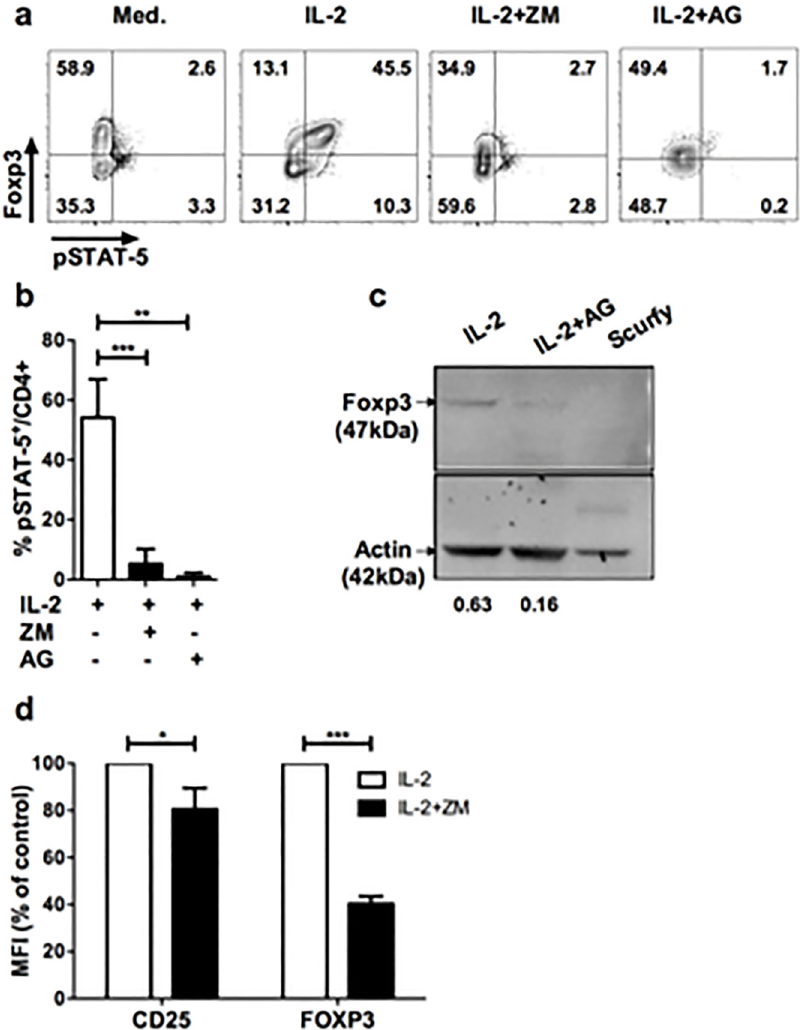
Fig 1. Blockade of JAK/STAT signaling pathway leads to down modulation of Foxp3 in Treg. ( a ) CD25-enriched T cells were cultured for one hour in complete medium alone (Med.), with IL-2 (IL-2), or IL-2 supplemented with ZM-39923 (IL-2+ZM) or AG-490 (IL-2+AG). Profiles shown are gated in CD4 + cells and are representative of 4 independent experiments. ( b ) Frequencies of pSTAT5 + cells among CD4 + cells cultured for one hour with IL-2 alone (IL-2) or in presence of IL-2 and the indicated JAK inhibitors (ZM, AG). Results are compiled from 4 independent experiments. (c) In vitro expanded CD4 + GFP + Treg were treated with IL-2 and with either 100ug/mL of AG490 (IL-2+AG) or vehicle control (absolute ethanol; EtOH) for 2 hrs (IL-2). Proteins were extracted in lysis buffer and blotted followed by anti-Foxp3 and anti-actin staining. Intensity values were normalized to the actin band in each blot. The specificity of the Foxp3 staining is attested by the absence of the Foxp3 band in extracts from splenocytes of a scurfy (genetically deficient for Foxp3) mouse. (d) Human CD4 + CD25 + cells were enriched from PBMC of healthy donors by magnetic sorting and treated with IL-2 (600 IU/mL) with or without ZM (50 μ M) for 1h. MFI of CD25 and FOXP3 in human CD4 + CD3 + cells after treatment with IL-2 alone (IL-2) or IL-2 in presence of ZM (IL-2+ZM). The MFI of Foxp3 and CD25 shown were normalized by the MFI of control cultures. These data are compiled from 3 independent experiments. Statistical significance was tested using Student t-test ( *** p < 0.001, ** p < 0.01, * p <